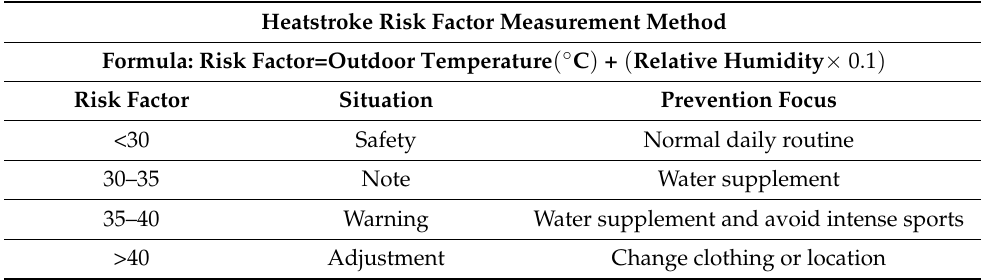
Table 2. Risk factor index for body and external temperature